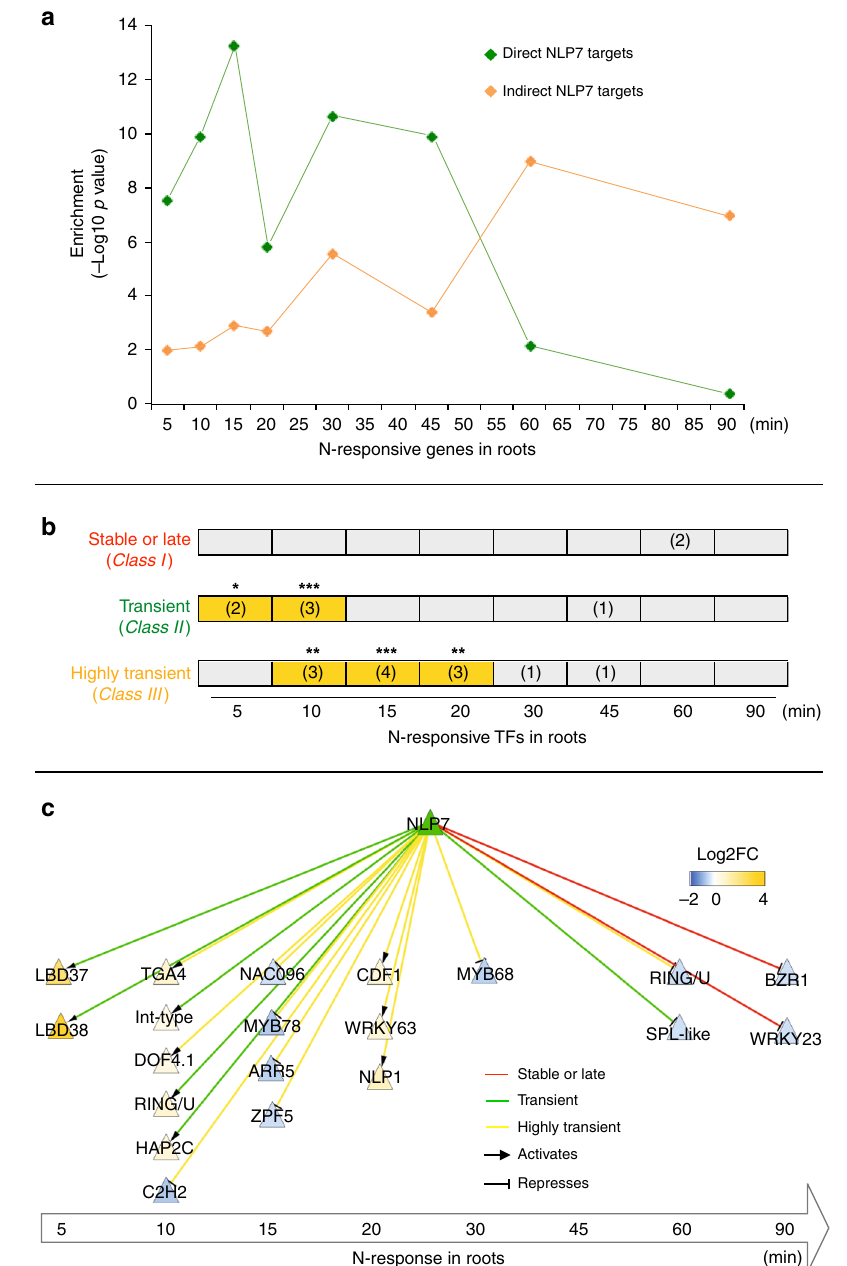
Fig. 3 NLP7-direct targets are enriched in early N-responsive genes including secondary TFs. a Intersection of NLP7-direct and indirect targets detected in root cells with a time-series of N-response genes in whole roots 19 . The time points represent the just-in-time analysis 19 which binned genes based on the fi rst time point at which their mRNA levels were affected by N treatment at 5, 10, 15, 20, 30, 45, 60, and 90 min. The signi fi cance ( p -value) of the intersection between NLP7 targets with each N-time point was calculated and − log10 ( p -value) was graphed. b Intersection of N-responsive secondary TFs regulated by NLP7 and genes belonging to each class of NLP7 binding. Size of overlap is listed in parentheses, and signi fi cance is indicated by yellow highlighting and asterisks (Fisher ’ s exact test, * p -value< 0.05; ** p -value < 0.01; *** p < 0.001). c The transcriptional network regulated by NLP7. NLP7 directly regulates the expression of N-responsive secondary TFs enriched in early time points of the N-response in roots. Node color depicts changes of transcript abundance of TFs in response to NLP7 nuclear import ( + DEX/ − DEX) (Supplementary Data 5). Edge color corresponds to the different NLP7 mode of kinases (CPK) to transcriptional regulation via NLP7 13 . Speci fi - plants. Collectively, NLP7-direct targets, NLP7 indirect targets and genes regulated by secondary TFs acting downstream of cally, the NLP7 cascade that we validated captured 53% of genes NLP7 regulate 53% of the N-responsive genes in whole roots dependent on the CPK pathway (164/310 genes; p -value 2.58E- (1420/2681 genes; p -value 1.41E-21, Fisher ’ s exact test; Supple- 24, Fisher ’ s exact test) 13 . mentary Data 27). These genes include the signaling cascade that links the nitrate-mediated regulation of Ca 2 + -sensor protein